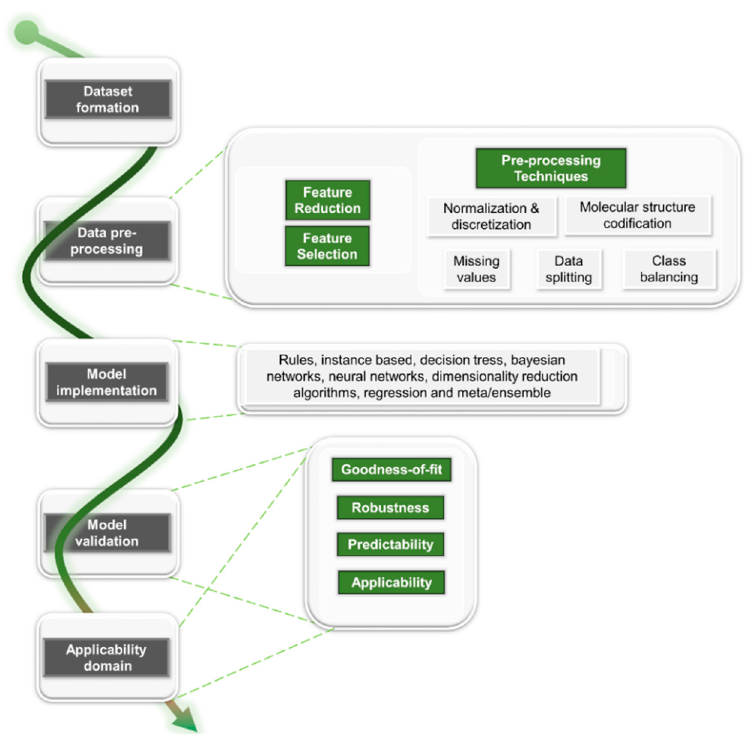
Figure 1. A summarized general roadmap for implementing a model in the field of nanotoxicology. The roadmap can be divided into five main parts: dataset formation, data pre-processing, model implementation, model validation, and applicability domain.